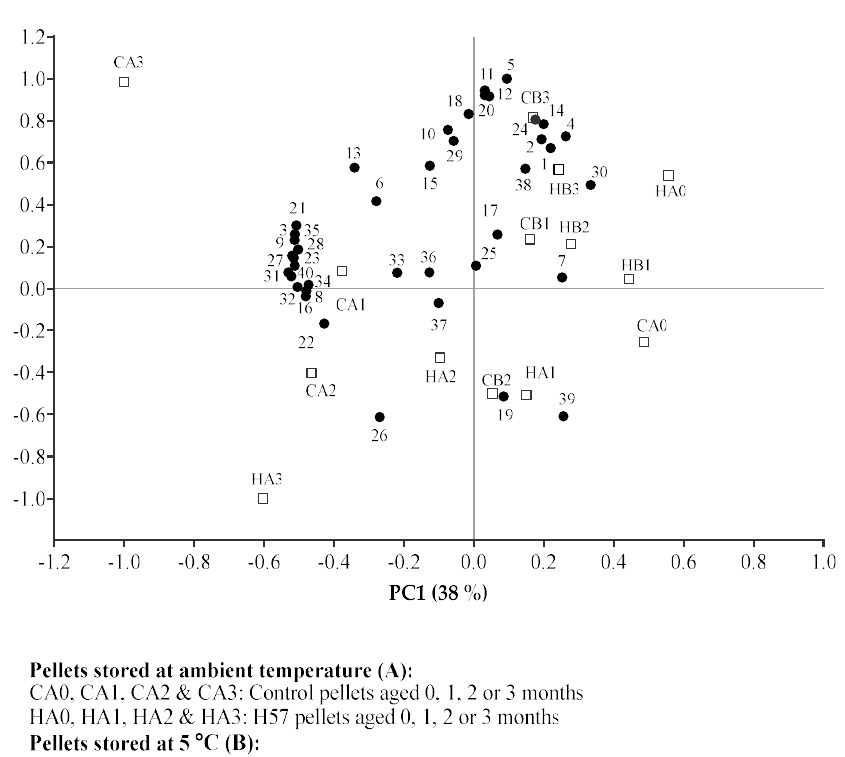
Figure 4. Pattern of correlations between the identified volatile organic compounds and pellet treatments in a bi-plot of the PCA analysis ( VOCs; □ pellet treatments). The numbers correspond to the compound names as in heatmaps of volatile organic compounds.